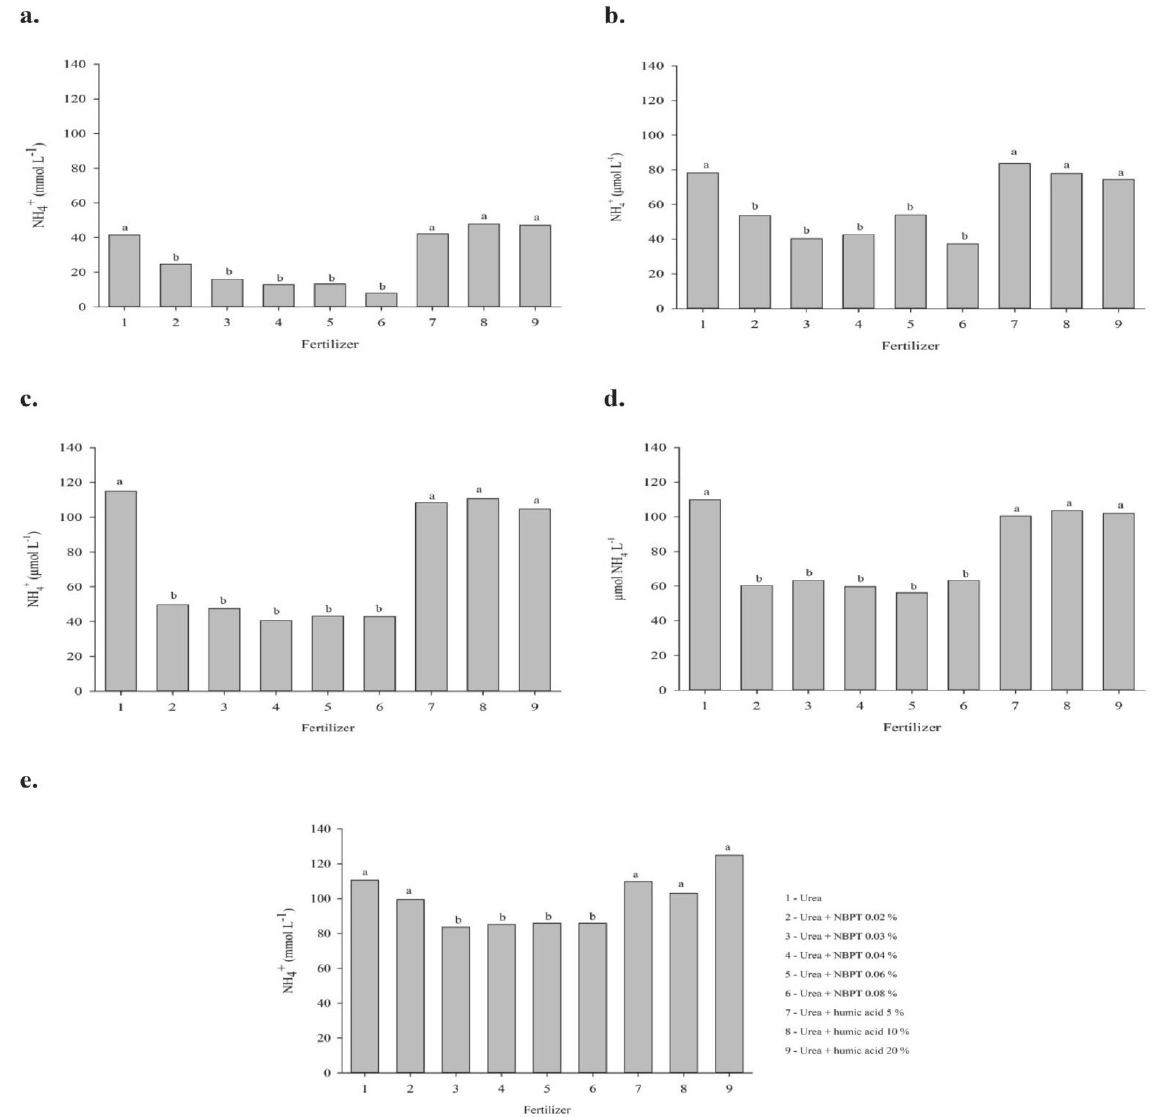
Figure 2 - Ammonium production, due to the hydrolysis of the conventional and additive urea, submitted to ( a. ) - 2, ( b. ) - 4, ( c. ) - 6, ( d. ) - 24 and ( e. ) - 36 hours of incubation. Different letters between the columns indicate difference by the Scott-Knott test at 5%. Analyzes carried out following proposed methodology Witte and Medina-Escobar